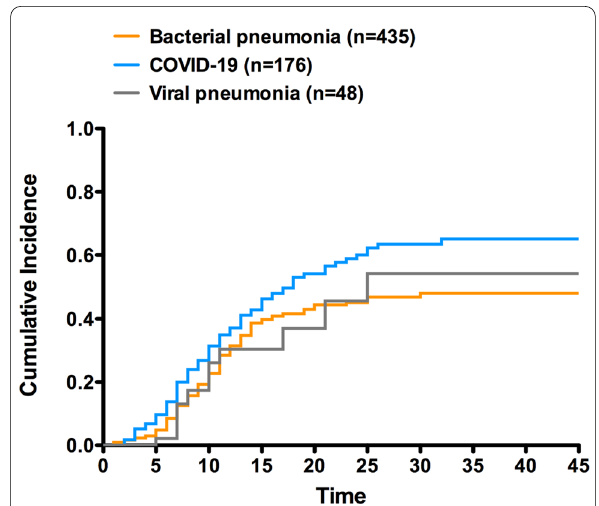
Fig. 1 Cumulative incidence of ventilator‑associated pneumonia among patients